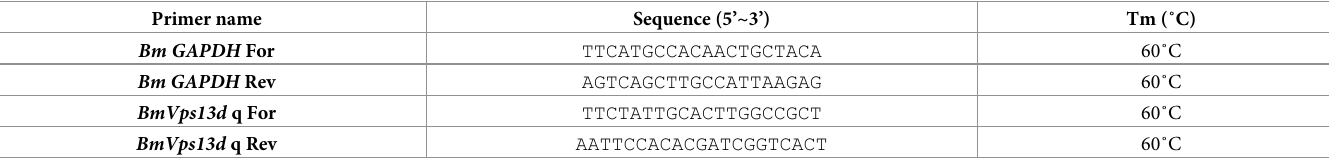
Table 1. Primers used for RT-qPCR